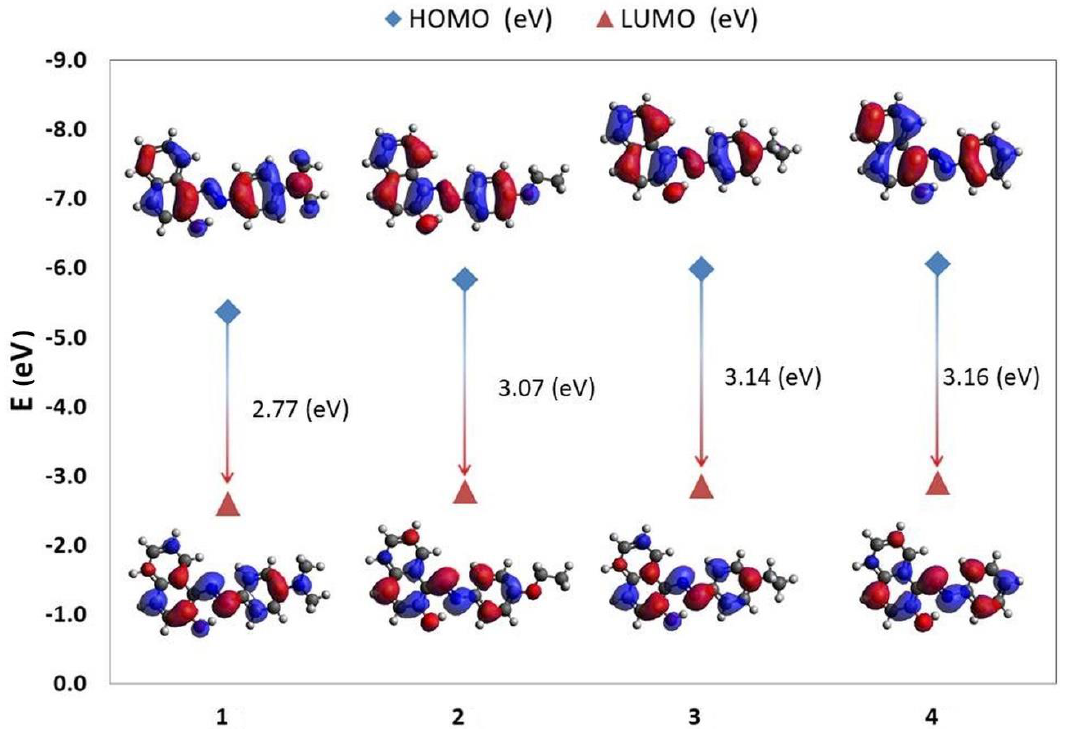
Figure 8. Graphic representation of HOMO and LUMO orbitals for azo forms of 1-phenylazonaphthalen-2-ols ( 1–4 ) calculated in